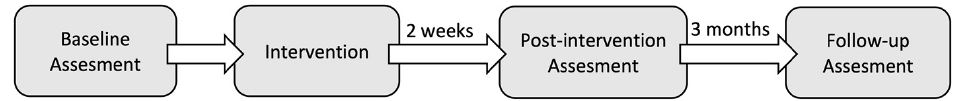
Figure 1. Dependent outcomes were assessed at three different times: Baseline, post-intervention and follow-up.